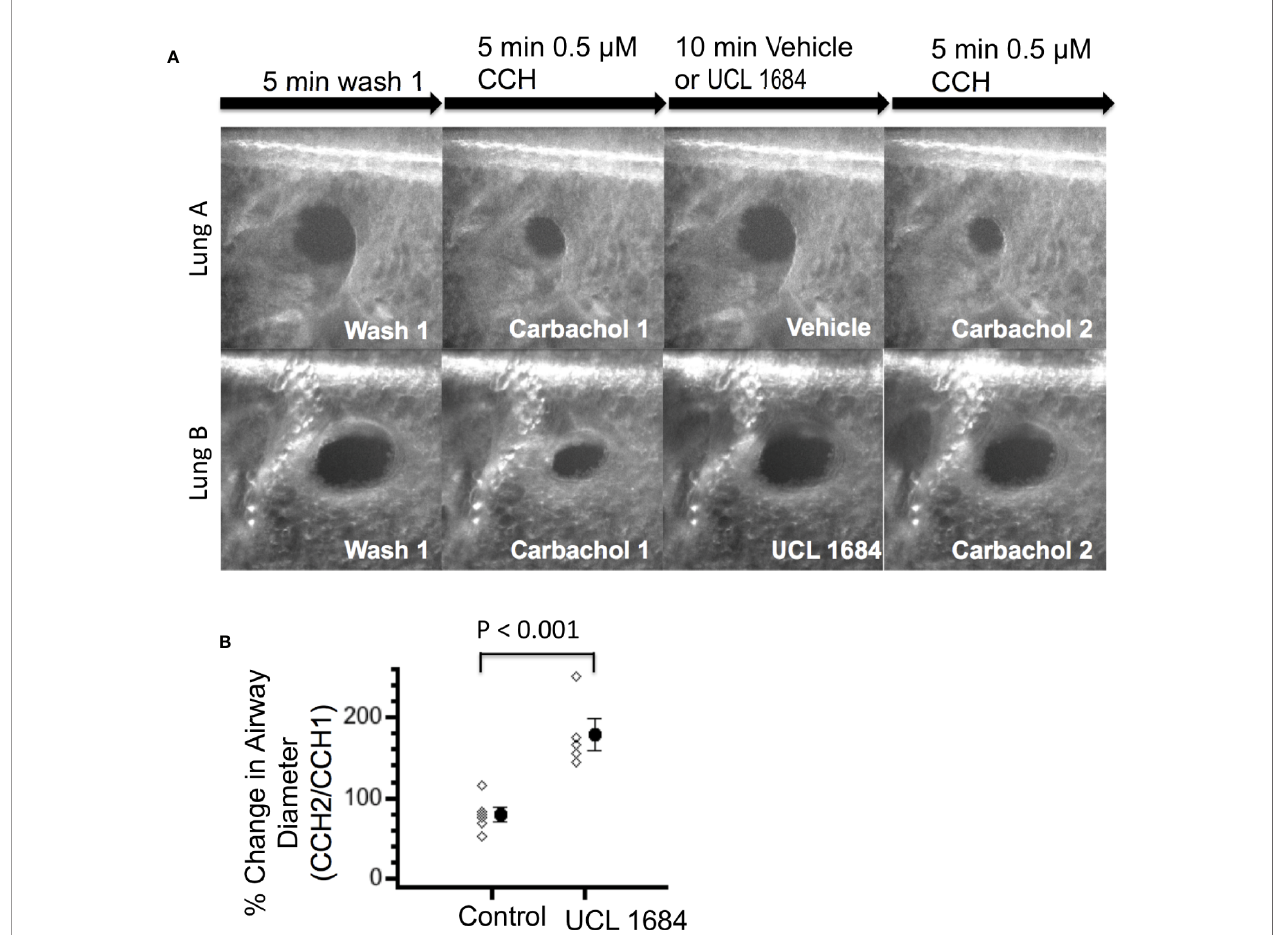
FIGURE 5 | UCL 1684 causes relaxation of mouse lung lower airways. (A) Example of reproducible bronchoconstriction in response to repeated exposure of 0.5 m M carbachol (top row). Identical experiments with additional superfusion of 3.5 m M UCL 1684 preceding second carbachol challenge (bottom row) indicates that UCL 1684 prevents bronchoconstriction. (B) Summary data of bronchial diameter during second carbachol challenge normalized to fi rst challenge (in percentage) was 79.0 ± 8.5, N=6 for control, and 178.3 ± 19.0, N=5 for UCL 1684 treated. P < 0.001 in Student ’ s